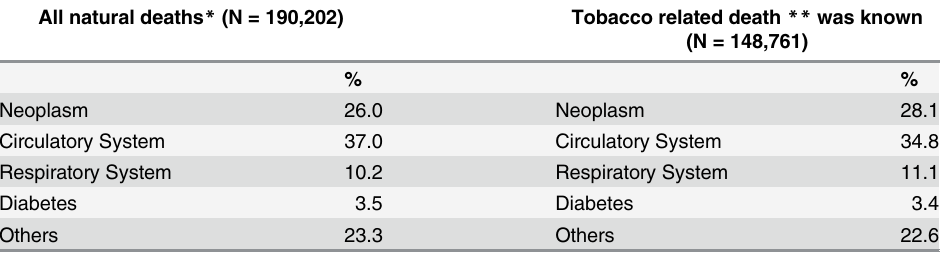
All natural deaths * (N =